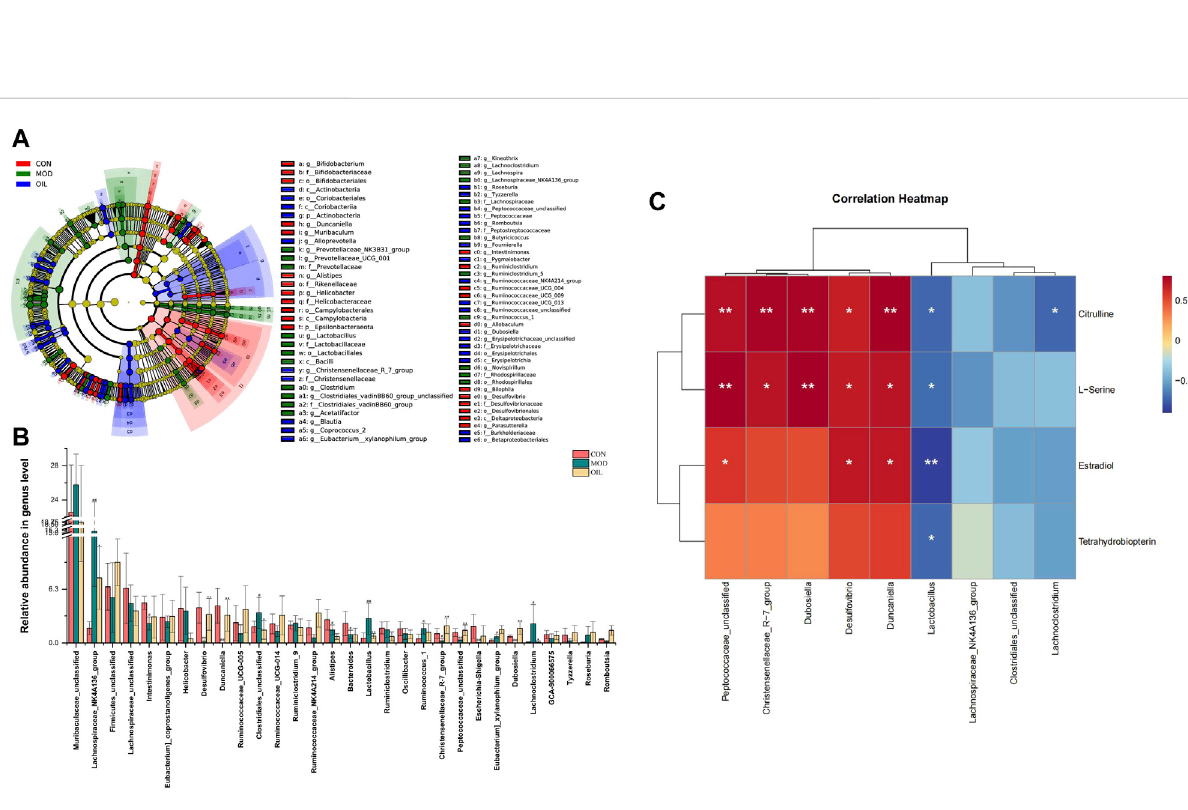
FIGURE 8 Intestinal microbial LEfSe from domain to species (A) . Statistical signi fi cance of the intestinal contents were calculated using ANOVA after administration of A. mongolica oil at the genus level (B) . * p < 0.05 and ** p < 0.01 compared to the model control group. # p < 0.05 and ## p < 0.01 compared to the control group. Spearman analysis of potential biomarkers and key difference gut microbes (C)